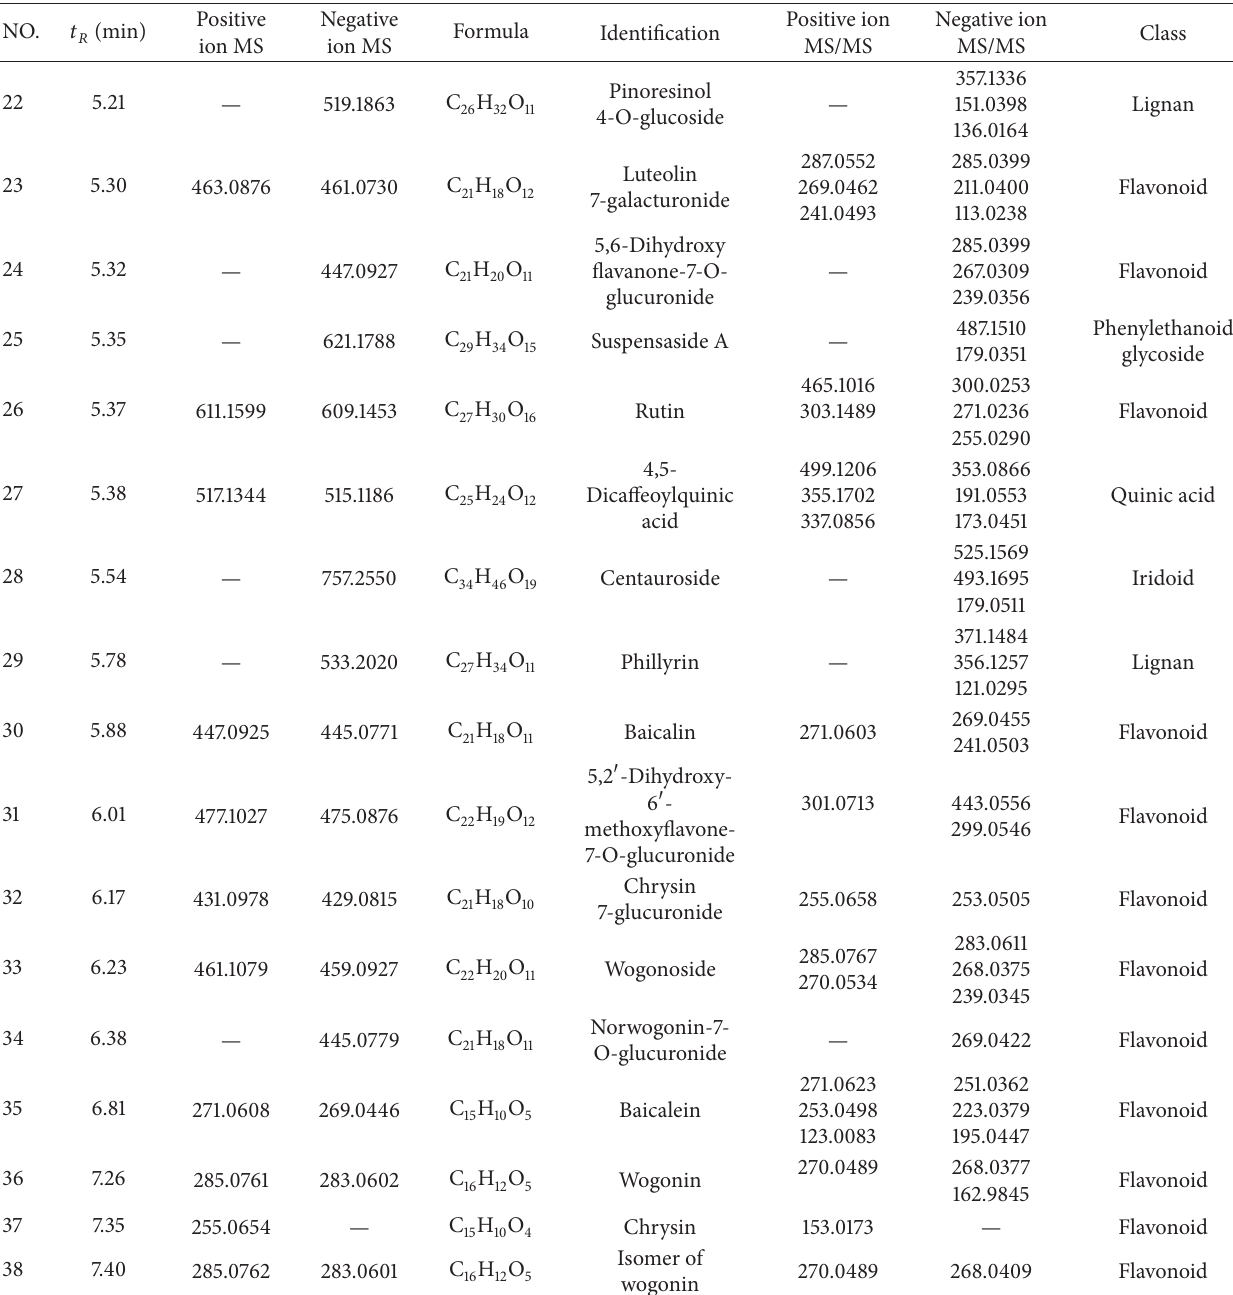
Figure 2 represented the typical BPI chromatograms